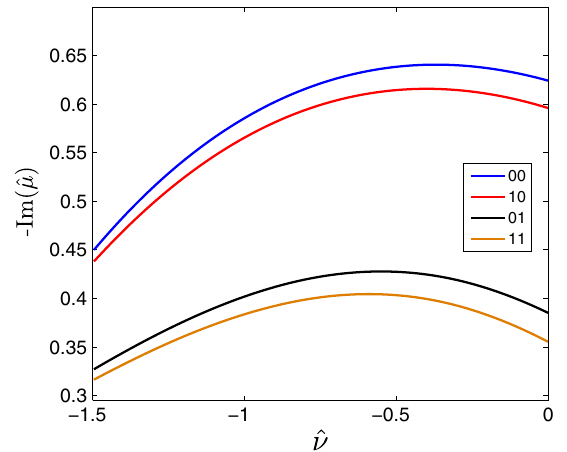
FIG. 2. Negative imaginary part of the FEL growth rate μ (in k units of 2 ρ ) as a function of the detuning Δ ν (in units of 2 ρ T u for various FEL modes (variational data for the η ¼ 1 cm